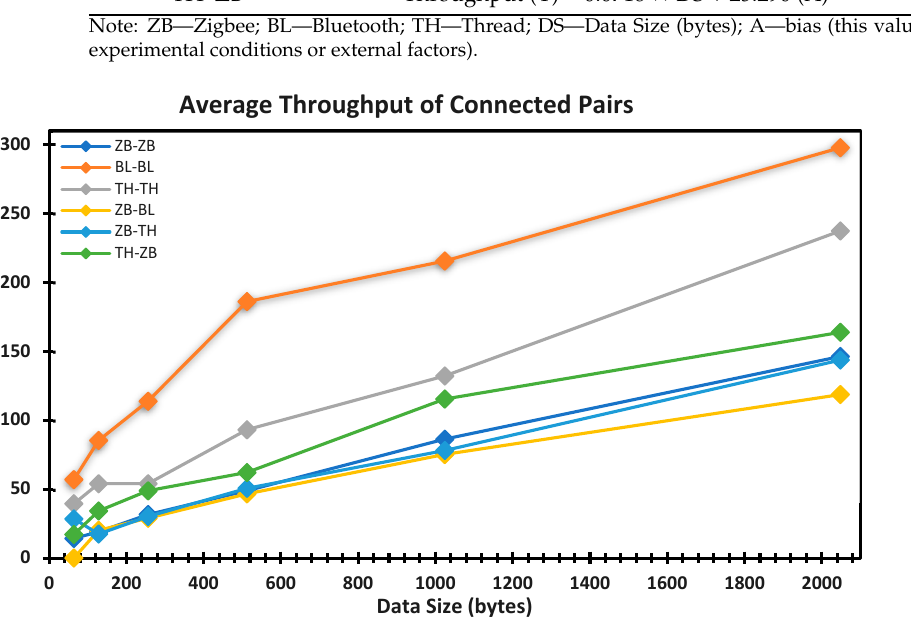
Figure 20. The graph shows a plot of the average throughput against data size with the best-fitted linear trendline. The regression models are tabulated in Table 6 below. Table 6. Univariate Regression Models Built Based on the Average Throughput.